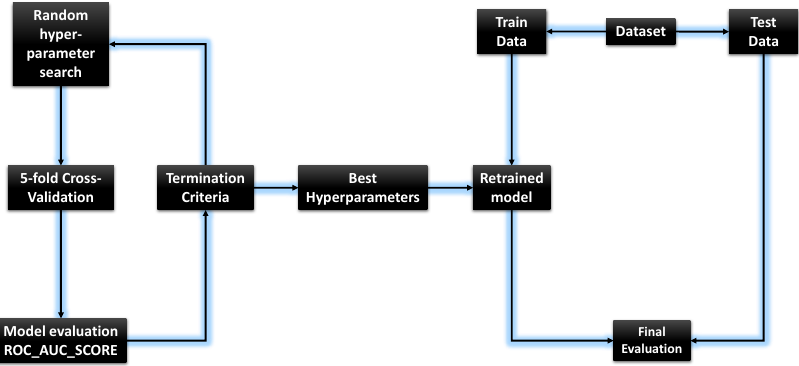
Figure 5. The schematic view of random hyperparameter search with 5-fold cross-validation